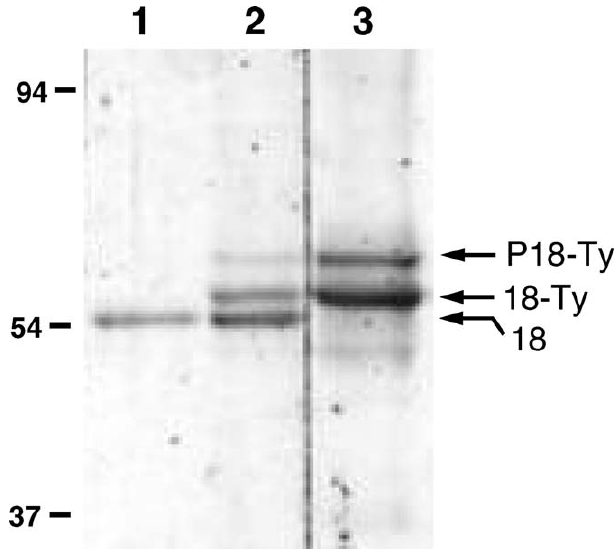
Figure 3. Western Blot Analysis of ROP 18 and ROP18-Ty